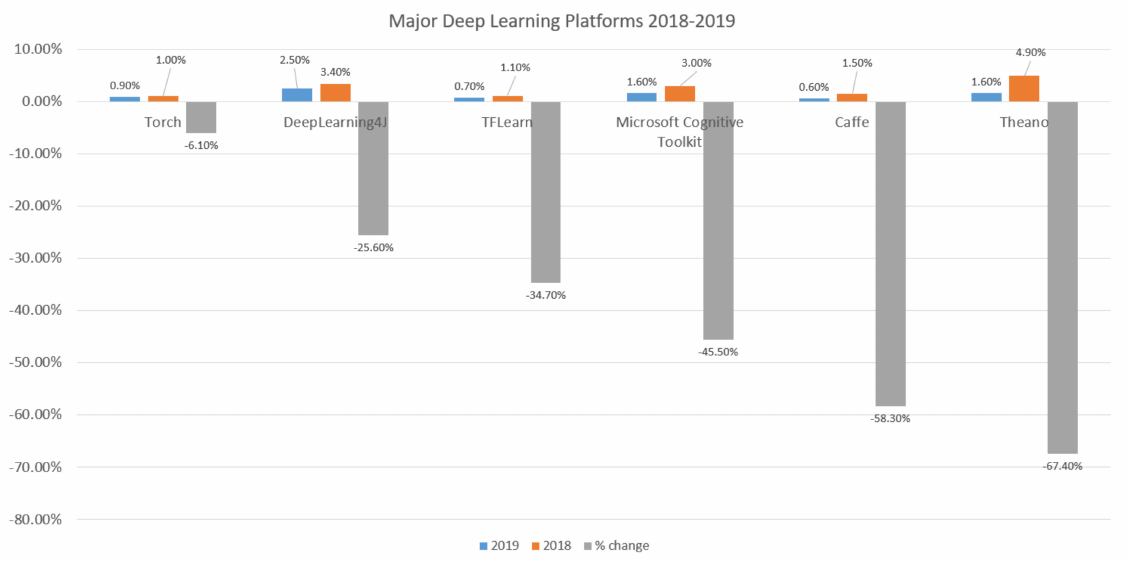
Figure 4. Graphical representation of the lowest adoption change (sorted by adoption change %) of deep learning platform as conducted by KDnuggets poll 2018–2019